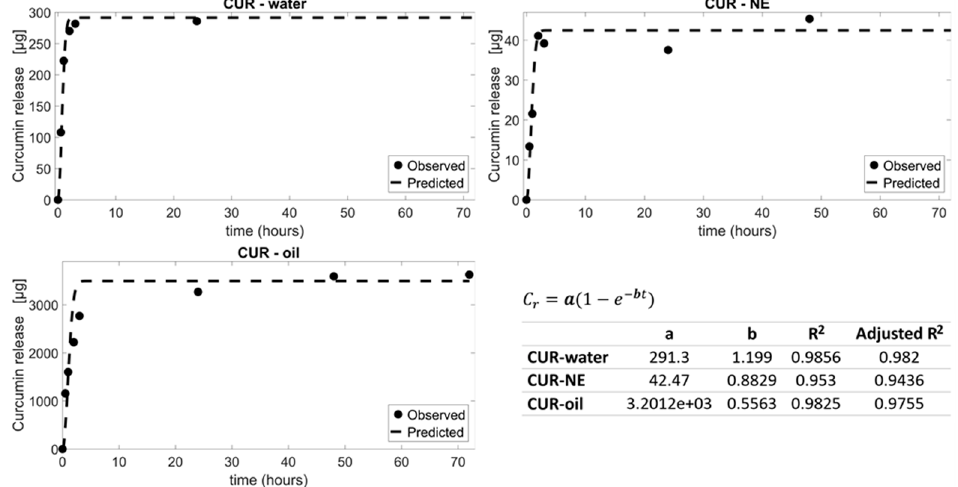
Figure 4. CUR–water, CUR–oil and CUR–NE experimental data were fitted with non-linear first-order models (dashed lines). The corresponding fitting parameters a and b are shownin the table as well as the R 2 and adjusted R 2 values.